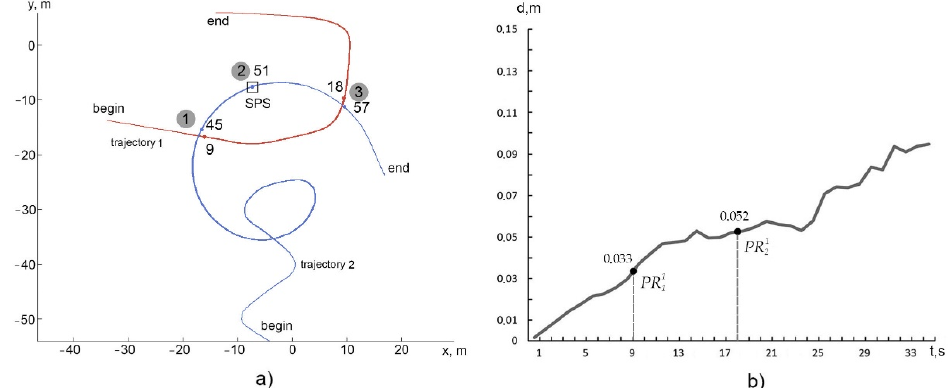
Figure 9. The virtual scene: ( a ) position numbers 9 and 18 of two PR 1 of VCRN are indicated on the AUV preliminary pass trajectory (trajectory 1). On the working trajectory (trajectory 2) the respective numbers 45 and 57 of the binding positions of AUV to these PR 1 of VCRN and the number 51 of the binding position to the SPS object are indicated. The trajectories are shown in the plane of the seabed; ( b ) the graph of the error of the preliminary run (trajectory 1). Points PR 1 and PR 1 of VCRN are formed at positions 9 and 18, respectively.